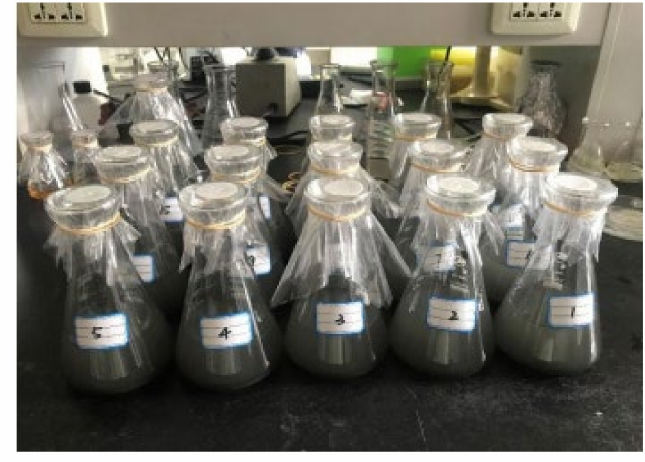
Figure 2. Box–Behnken experimental samples.